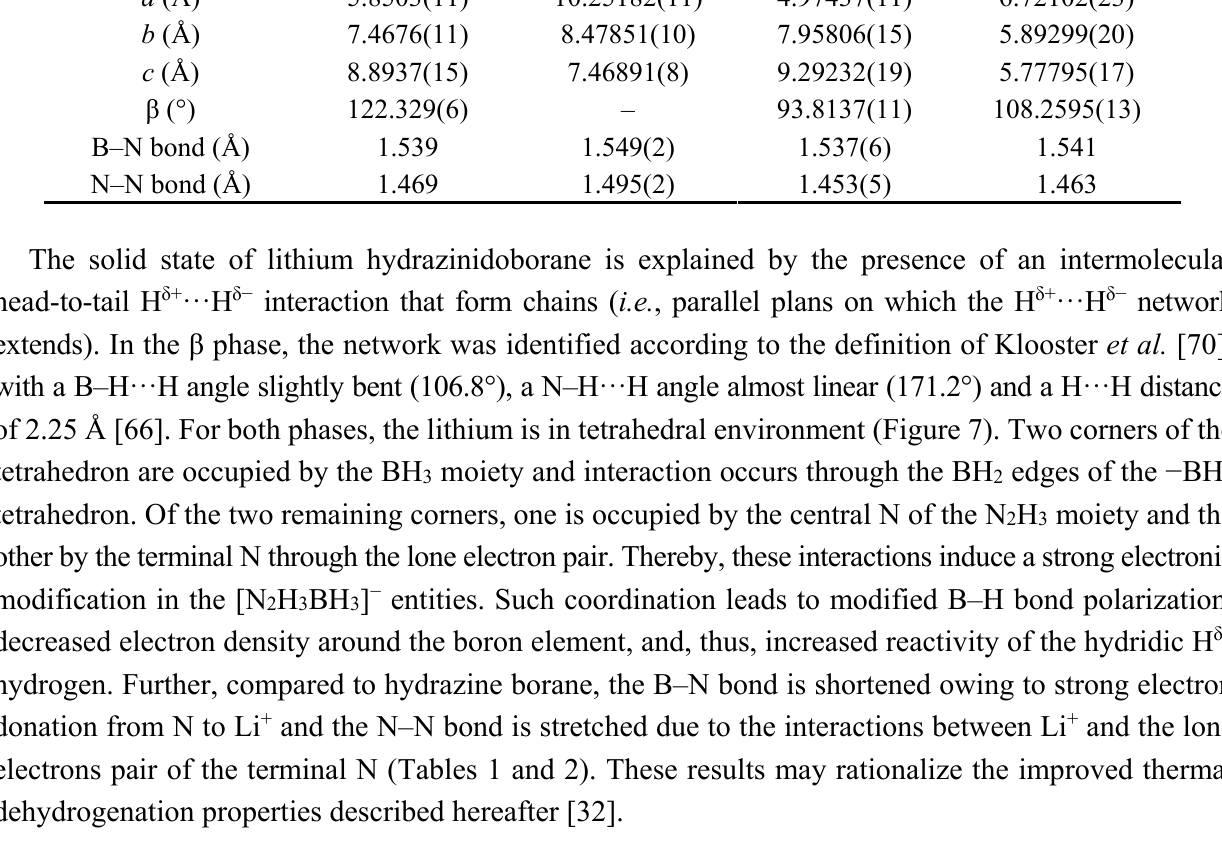
Crystal system Space group